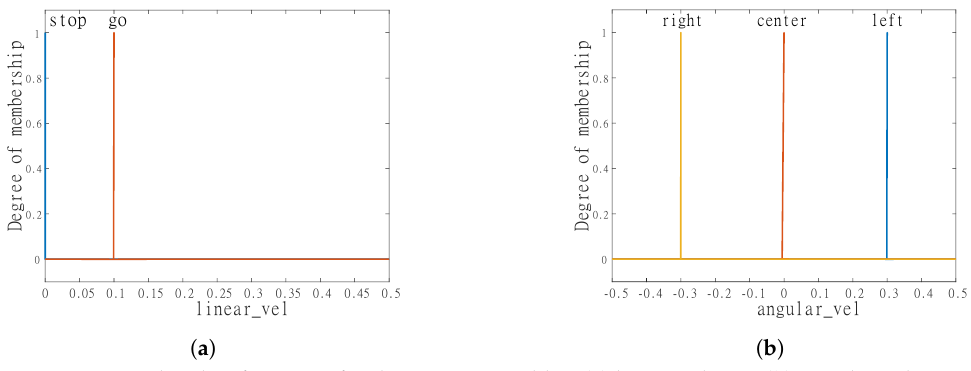
Figure 4. Membership functions for the output variables: ( a ) linear velocity, ( b ) angular